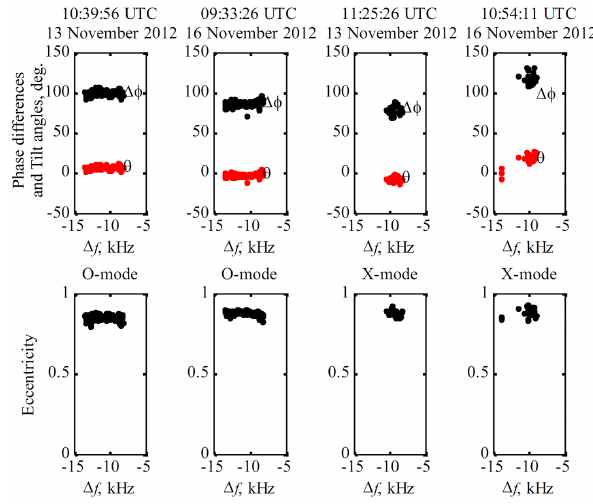
Figure 4. Plots of the phase difference (cid:49)ϕ , the angle of rotation of the polarization ellipse θ (upper panel) and eccentricity e (lower panel) of the DM component of the